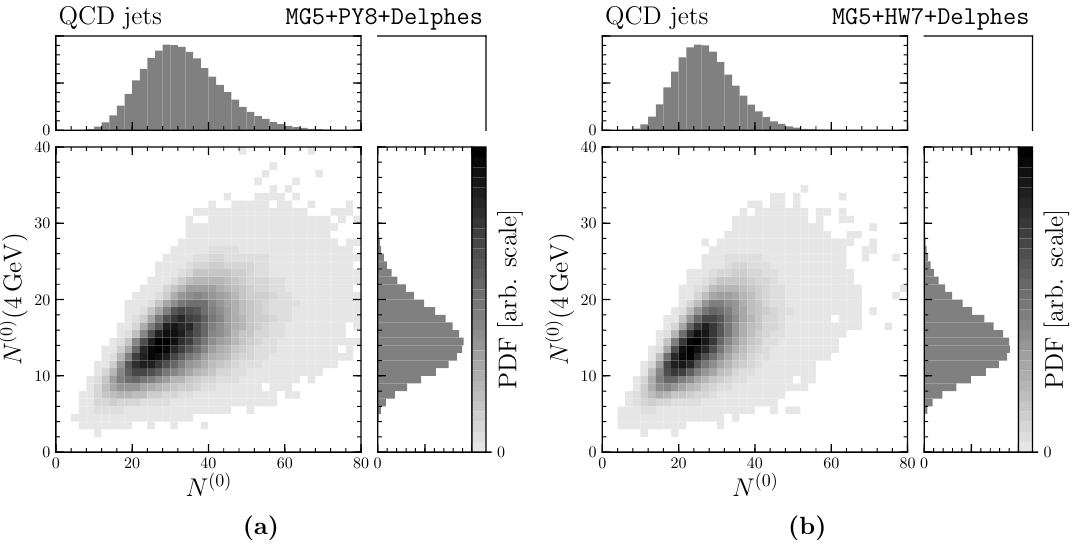
Figure 17. ( N (0) ; N (0) (4 GeV)) distributions for (a) PY8 and (b) HW7 .